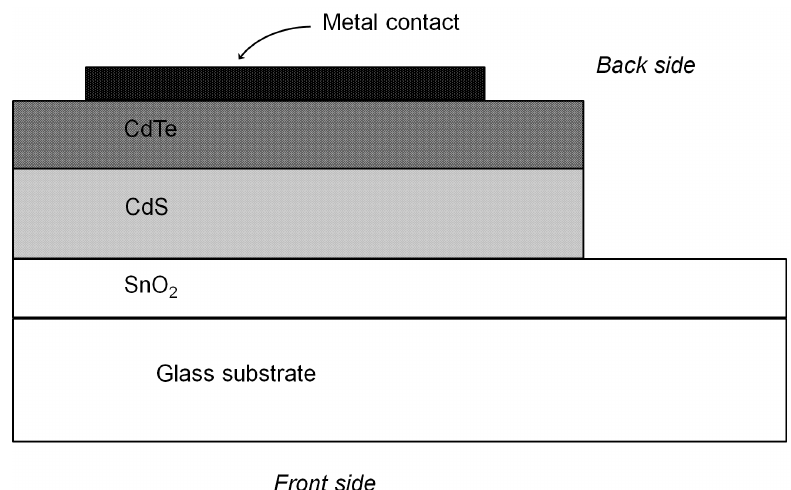
Figure 1. The glass substrate represents the front side of a solar cell and the CdTe layer represents the backside of a solar cell. The glass substrate, SnO 2 , and CdS layers are transparent to a 658 nm line that is absorbed only by the CdTe film at the interface (junction luminescence).